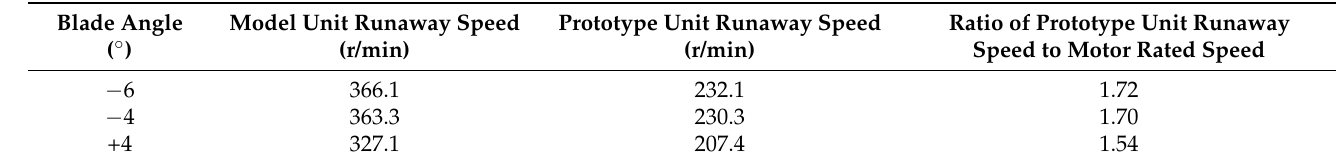
Table 5. Runaway speed data of the prototype pump under different blade placement angles ( H max = 2.22 m).